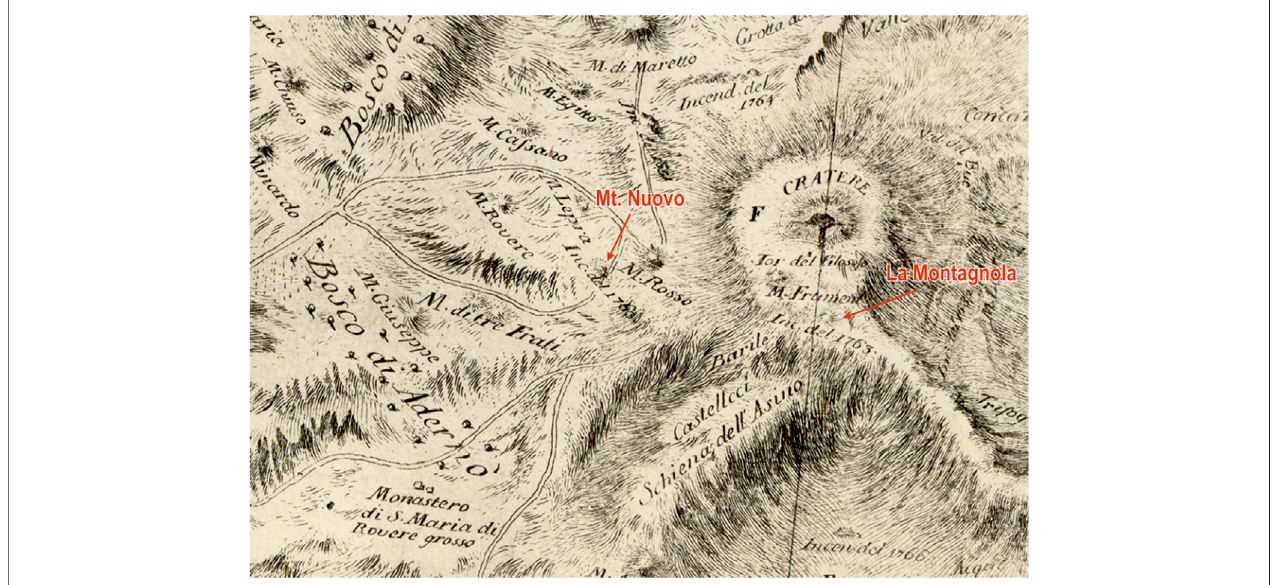
FIGURE3| Detailoftheoryctographic MapofEtna,fromRecupero(1815).The1763eruptionofMt.NuovoislocatedintheareaofMt.RossoandMt.Lepreinthe west fl ank of the volcano; the 1763 eruption of La Montagnola is drawn in the upper south fl ank of the volcano.